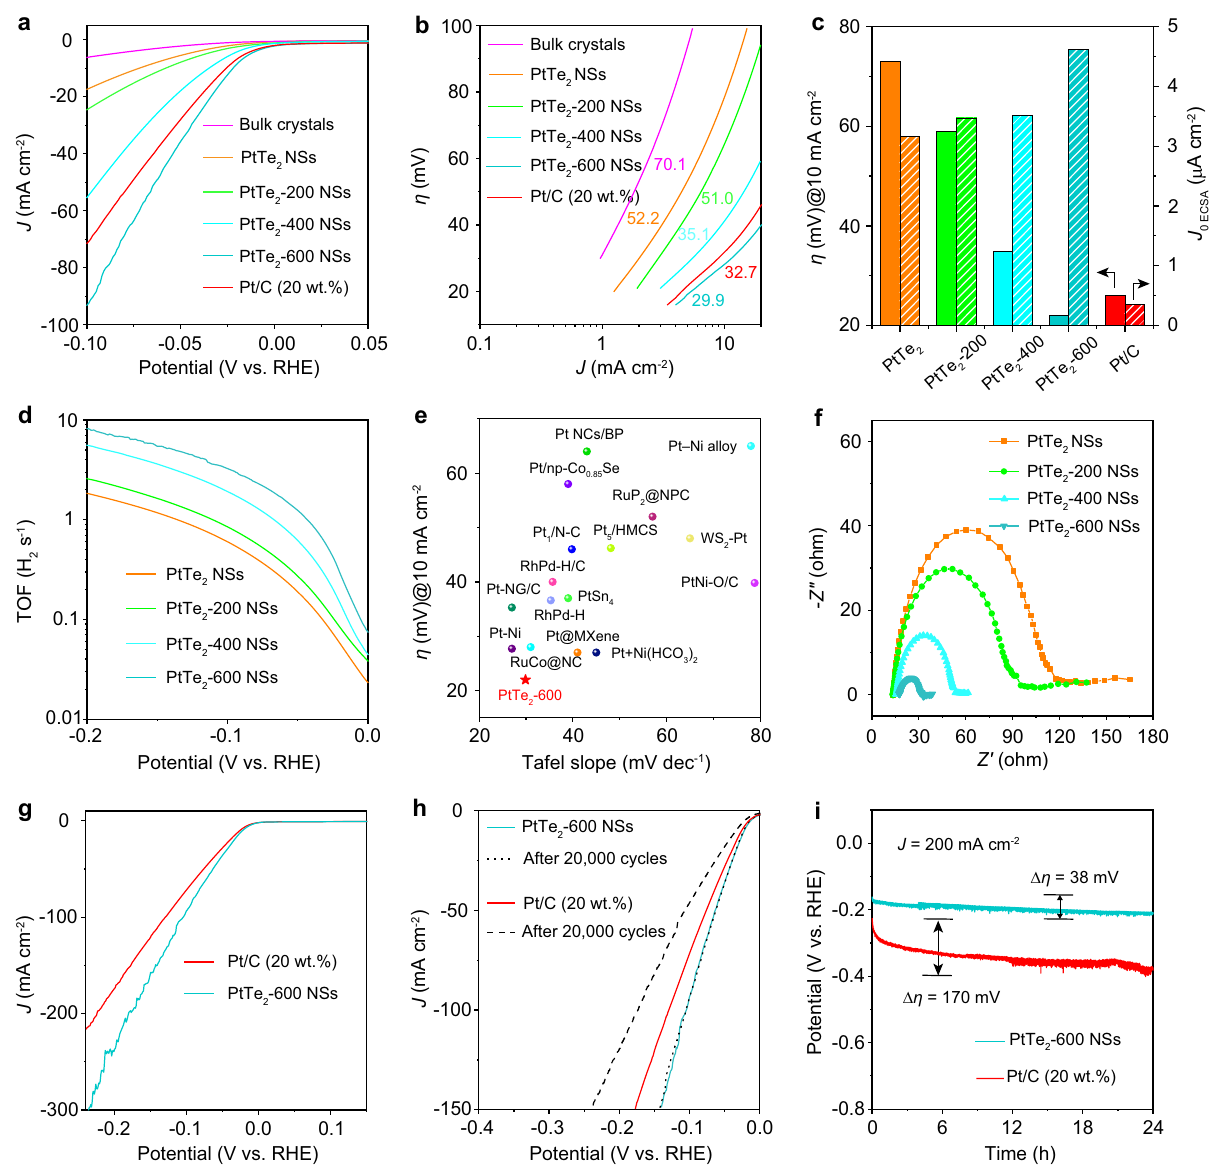
Fig. 3 HER performance. a LSV curves of bulk PtTe 2 crystals, PtTe 2 NSs, PtTe 2 -200 NSs, PtTe 2 -400 NSs, PtTe 2 -600 NSs, and Pt/C recorded in 1.0 M KOH at a scan rate of 5 mV s − 1 , with 80 % iR compensation. b The corresponding Tafel plots. c Comparison of overpotential at 10 mA cm − 2 and J 0 ECSA . d The potential-dependent TOF curves for PtTe 2 NSs, PtTe 2 -200 NSs, PtTe 2 -400 NSs, and PtTe 2 -600 NSs. e Performance comparison of PtTe 2 -600 NSs with other reported noble metal-based HER catalysts with high activity in 1.0 M KOH. The detailed information of these catalysts was listed in Supplementary Table 2. f Nyquist plots collected at an overpotential of 100 mV. g Comparison of LSV curves for PtTe 2 -600 NSs and Pt/C at large current density. h LSV curves of PtTe 2 -600 NSs and Pt/C before and after 20,000 cycles of accelerated CV test. i Chronopotentiometry measurement recorded at 200 mA cm − 2 for 24 h without iR